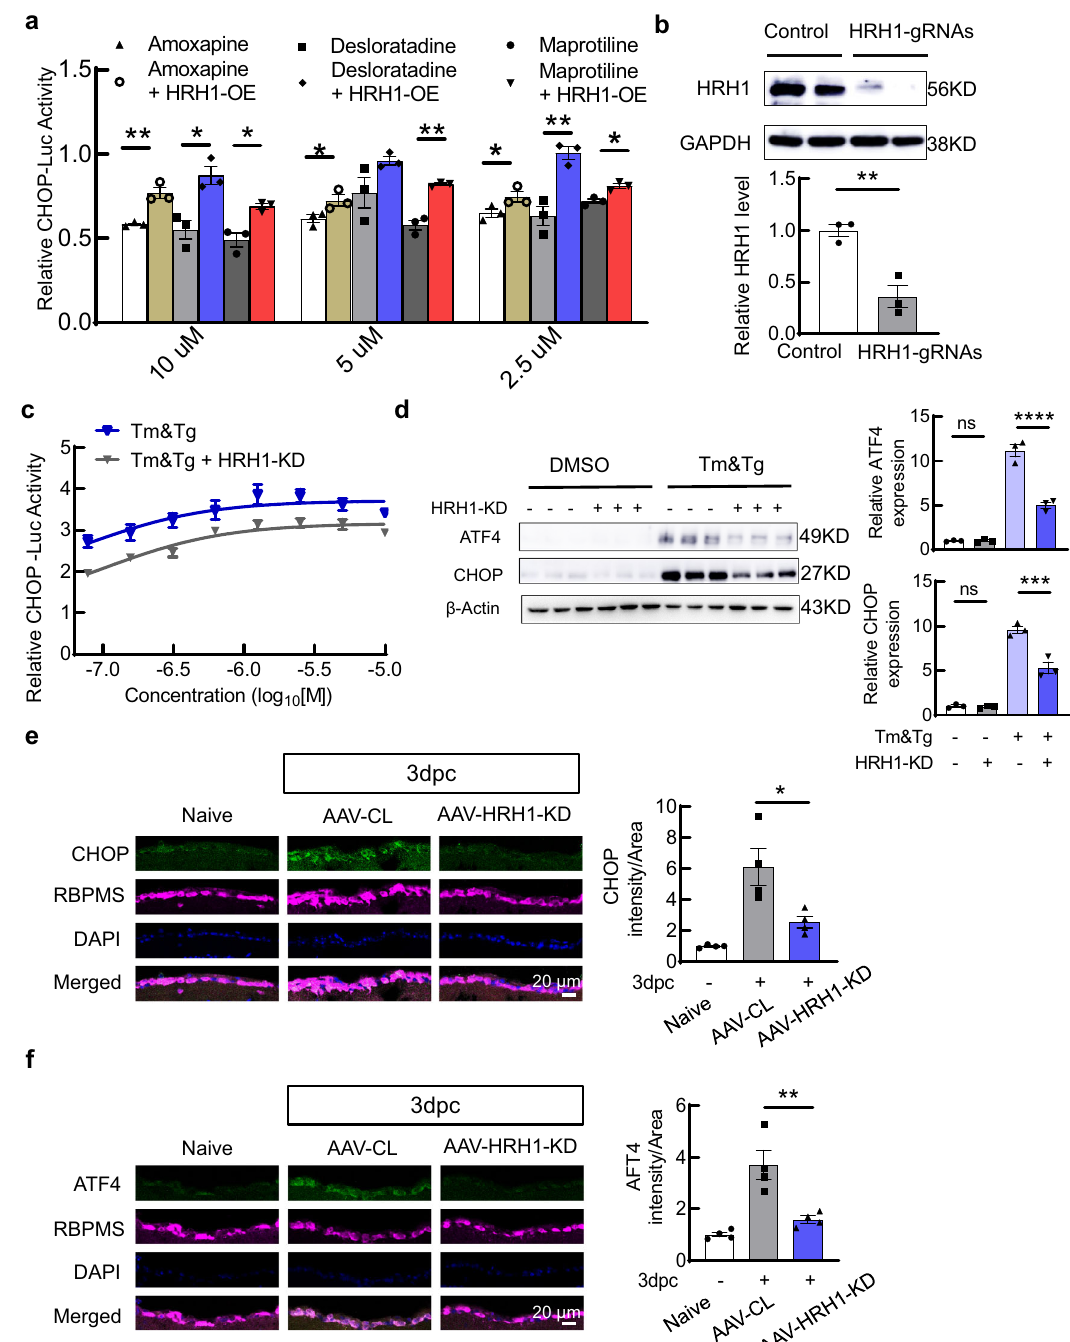
Fig.6|TheeffectsonERstressmodulationofHRH1,thecommontargetofthe three hit compounds. a Relative CHOP-Luc activities of the three compounds at indicated concentrations in the presence of Tm/Tg (1 µ M), with or without HRH1 overexpression (OE), relative to DMSO, 24h after exposure. n =3 independent replicates. * P <0.05, ** P <0.01, with a two-tailed unpaired Student ’ s t-test. b Immunoblot of HEK293T cells showing the CRISPR-mediated HRH1 KD and quanti fi cation of HRH1 protein levels. n =3 independent replicates. ** P <0.01, with a two-tailed unpaired Student ’ s t-test. c Relative CHOP-Luc ( n =5 independent replicates) activities in response to Tm/Tg at indicated concentrations, with or